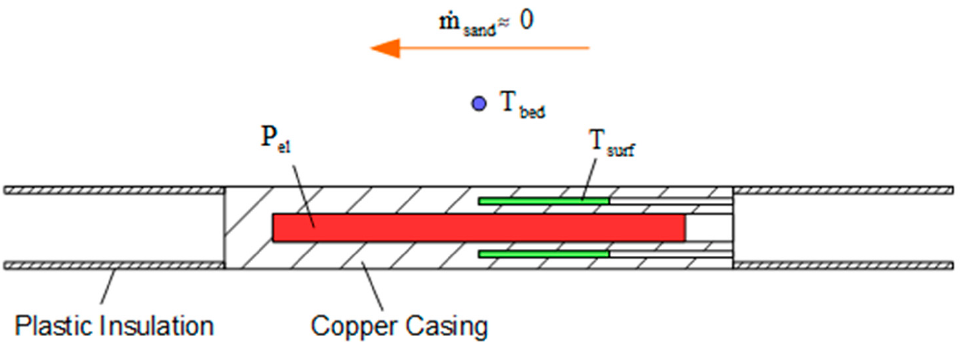
Figure 4. MICRO test tube configuration.